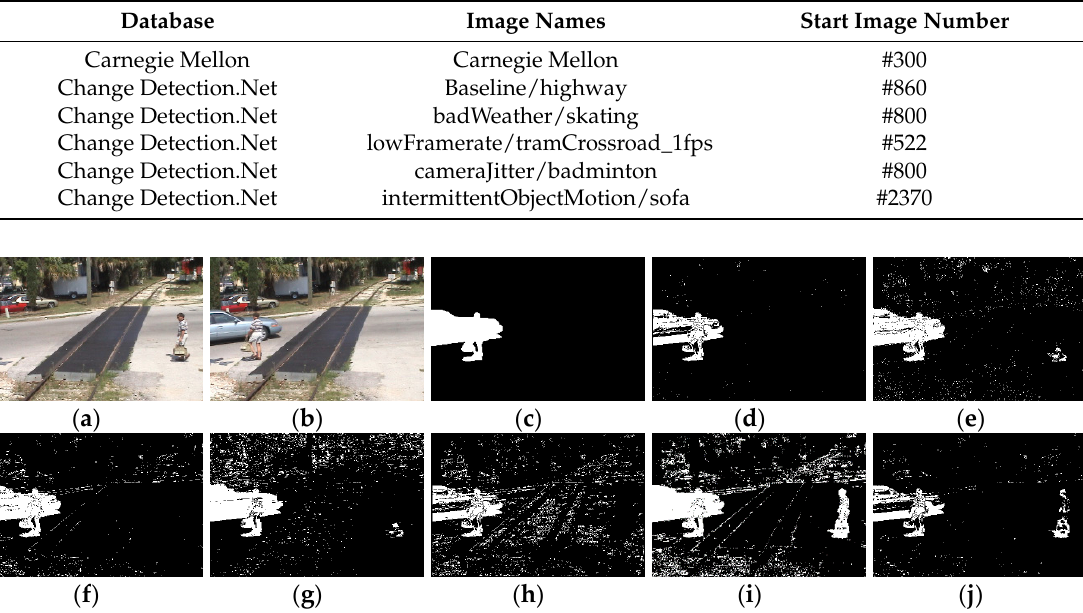
Table 3. Selected images and the start time of detection.